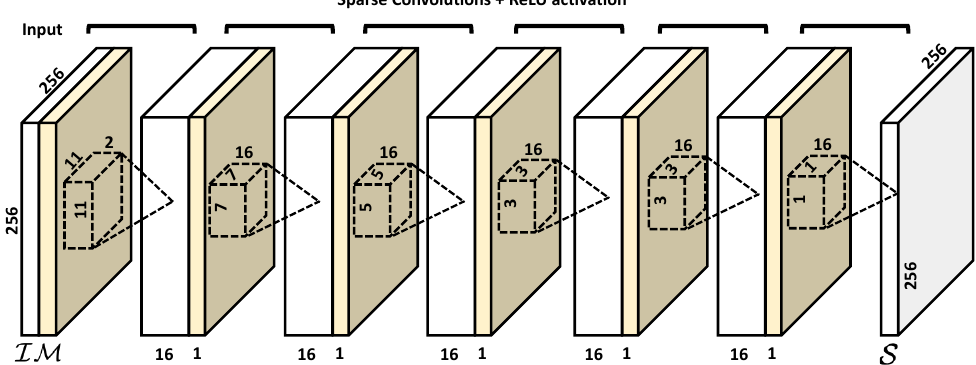
Figure 4. The depth completion block involves a sequence of sparse convolution layers (see Figure 5), interleaved by ReLU